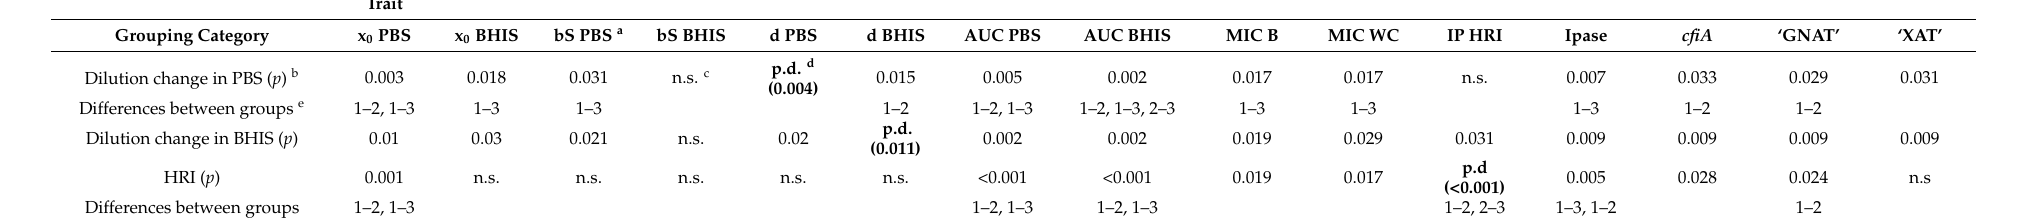
Table 2. Variance analysis of the examined traits of the test B. fragilis